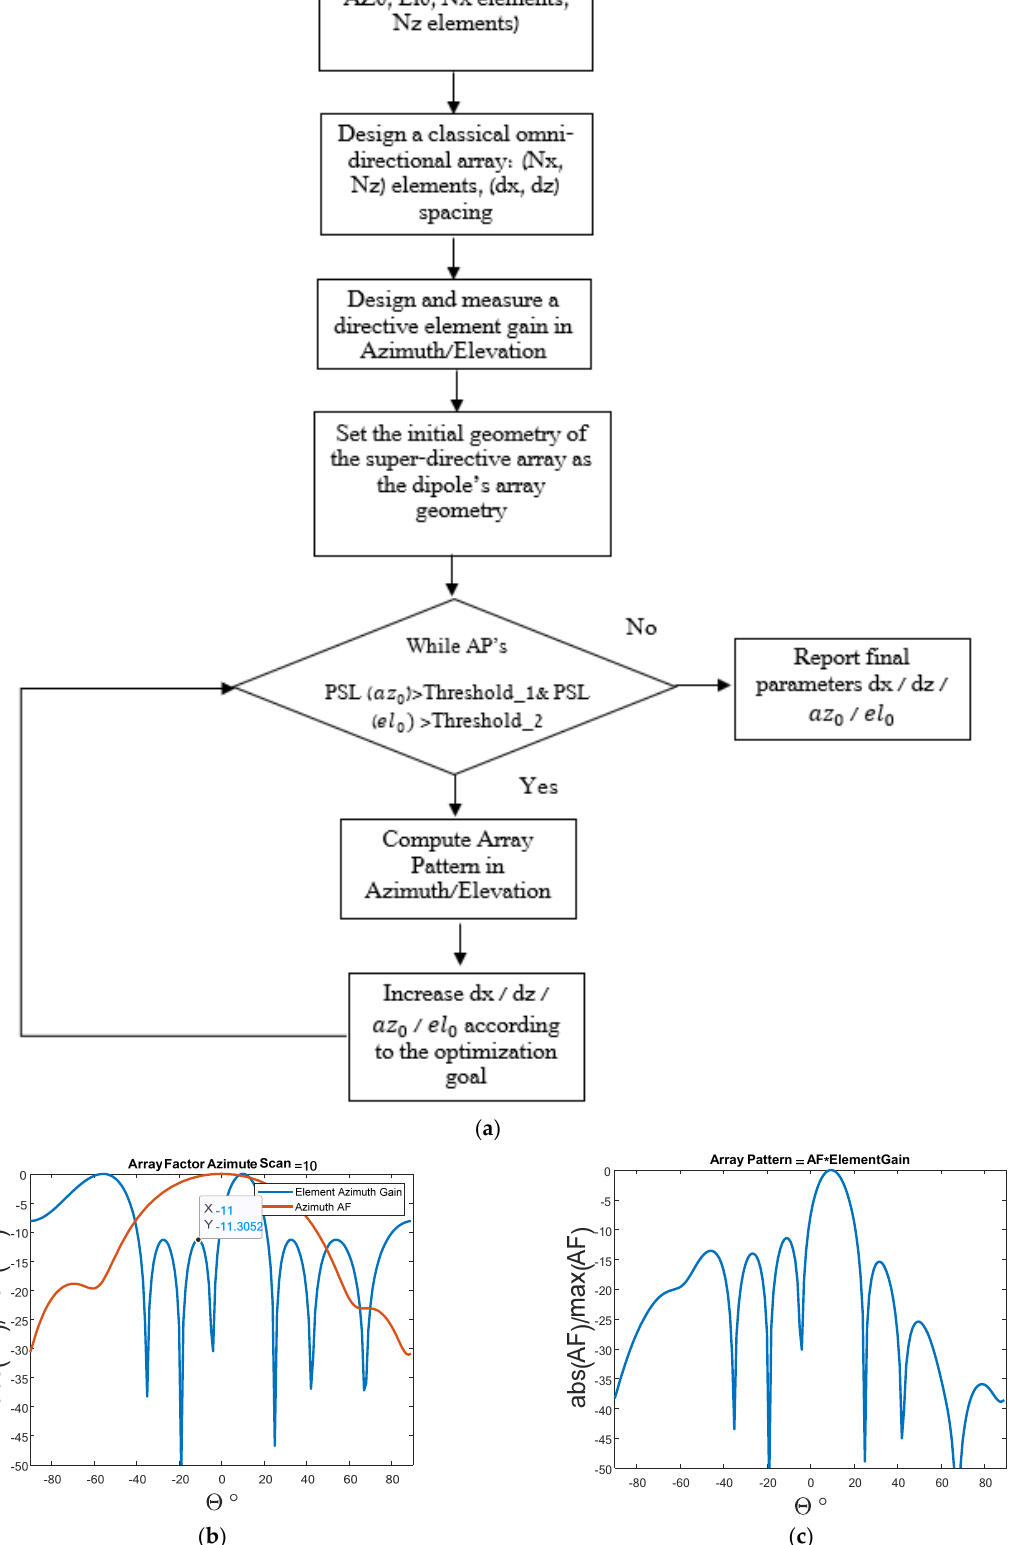
Figure 2. ( a ) Flow chart of a super-directive array design; ( b ) Yagi–Uda element and AF with a 10° azimuth scan; ( c ) Azimuth array pattern based on a Yagi–Uda element with a 10° azimuth scan.